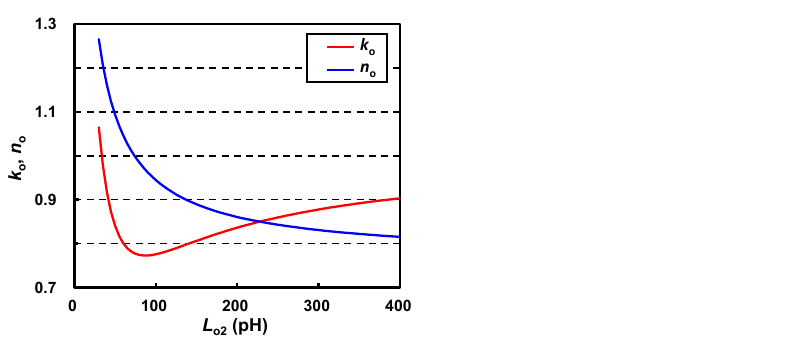
Figure 4. Calculated k o and n o according to Equations (2) and (3) for L o2 ranging from 30 to 400 pH.